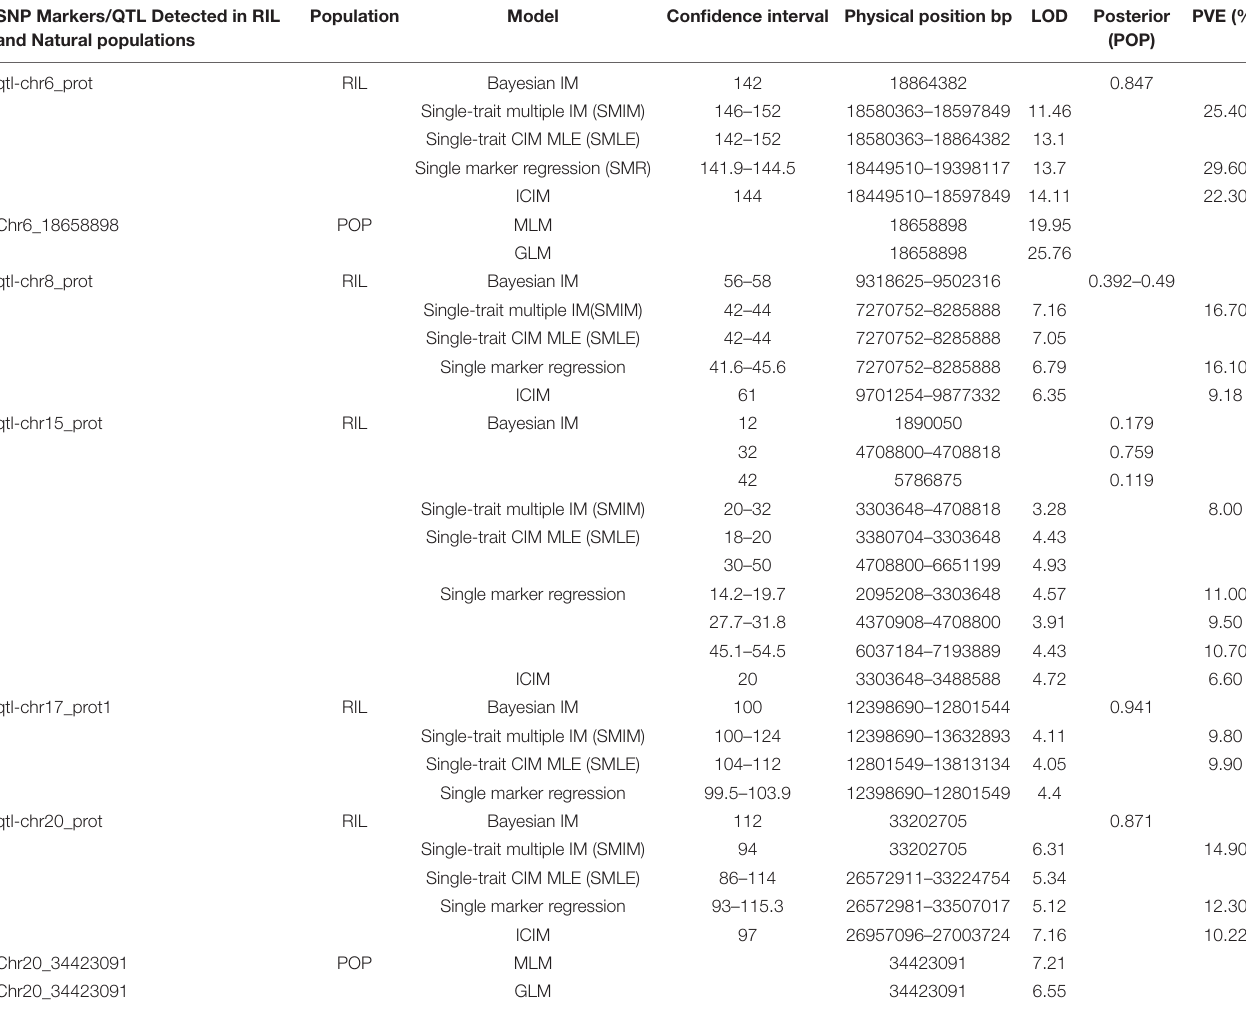
TABLE 1 | Single nucleotide polymorphism (SNP) markers/quantitative trait locus (QTL) detected in recombinant inbred line (RIL) and natural populations. SNP Markers/QTL Detected in RIL and Natural